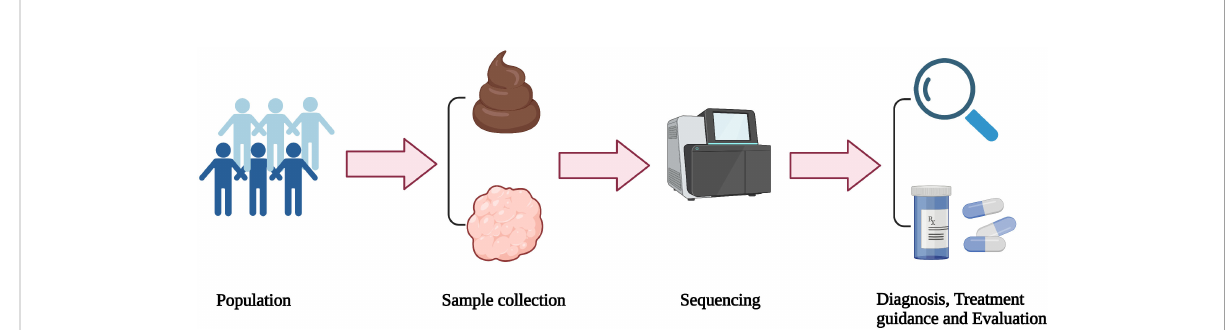
FIGURE 3 Application and transformation of microbiome. Stool and/or tumor samples from the population are collected and then sequenced. According to the analysis of the sequencing results, glioma patients can be diagnosed and classi fi ed, as well as guided personalized